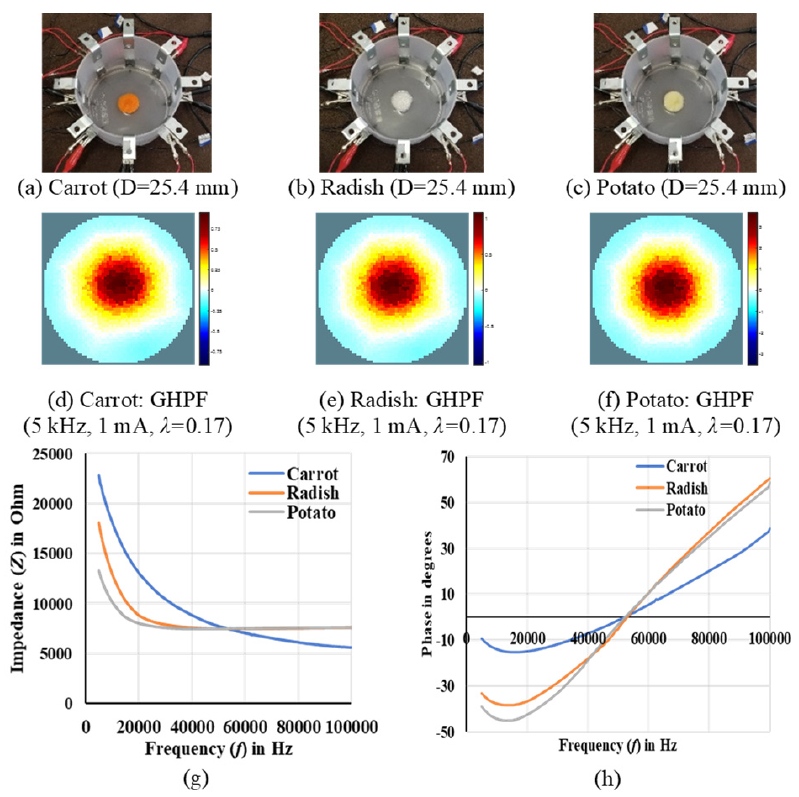
( d ) Figure 12. A carrot slice at ( a ) pos: 7, and the reconstructed images for the hyperparameter value ( λ ) of ( b ) 0.97, ( c ) 0.57, and ( d ) 0.17 at 80 kHz and 1 mA considering Laplace algorithm. The shape of the inhomogeneity changes with the decrease in hyperparameter value. The conductivity is increased, and the obtained maximum conductivity values are 0.71, 0.73, and 0.9 S/m, respectively. Experiment 2: In another experiment, three different edible plant slices of carrot, radish, and potato of a 1/3-inch height with a diameter, D = 25.4 mm of each were taken in the EIT domain and their reconstructed results were obtained using the impedance imaging technique in the 2D plane (using ‘d2d4c’), as shown in Figure 13. In this case,